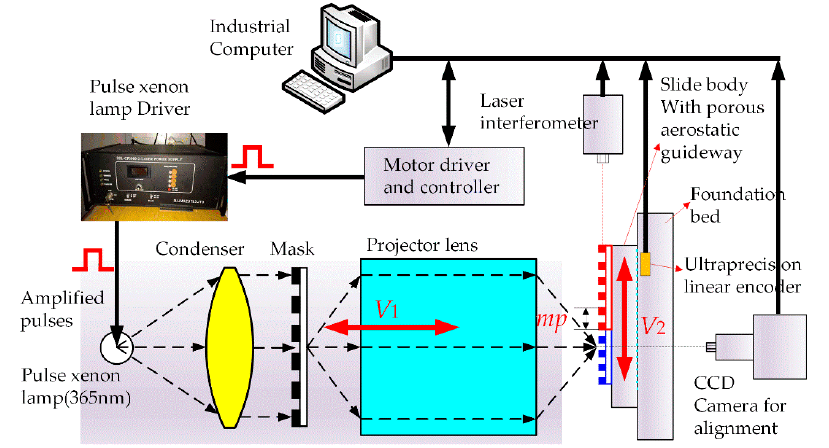
Figure 6. Schematic of the experimental setup.